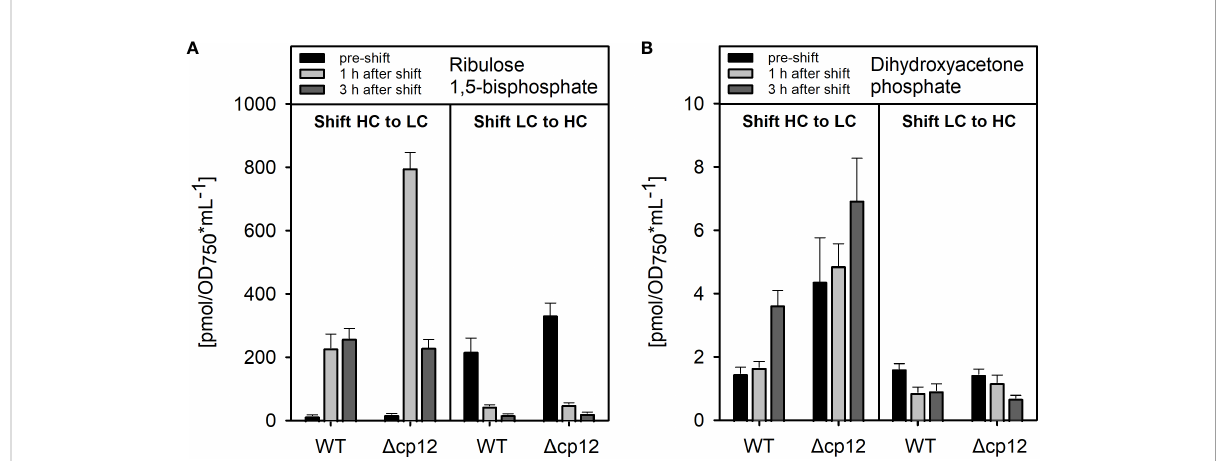
FIGURE 2 Metabolome analysis of products from the CP12-regulated enzymes PRK and GapDH2. The amounts of dihydroxyacetone phosphate (A) and ribulose 1,5-bisphosphate (B) were quanti fi ed by LC-MS/MS in cells of Synechocystis wild type (WT) or mutant D cp12 pre-acclimated to high CO 2 conditions (5% CO 2 , HC) or ambient air with low CO 2 (0.04% CO 2 , LC) (black columns – pre-shift). Then, cells were shifted for one (light grey columns) or three hours (dark grey columns) from either HC into LC or LC into HC conditions. Metabolite levels are mean values ± standard deviations from three biological